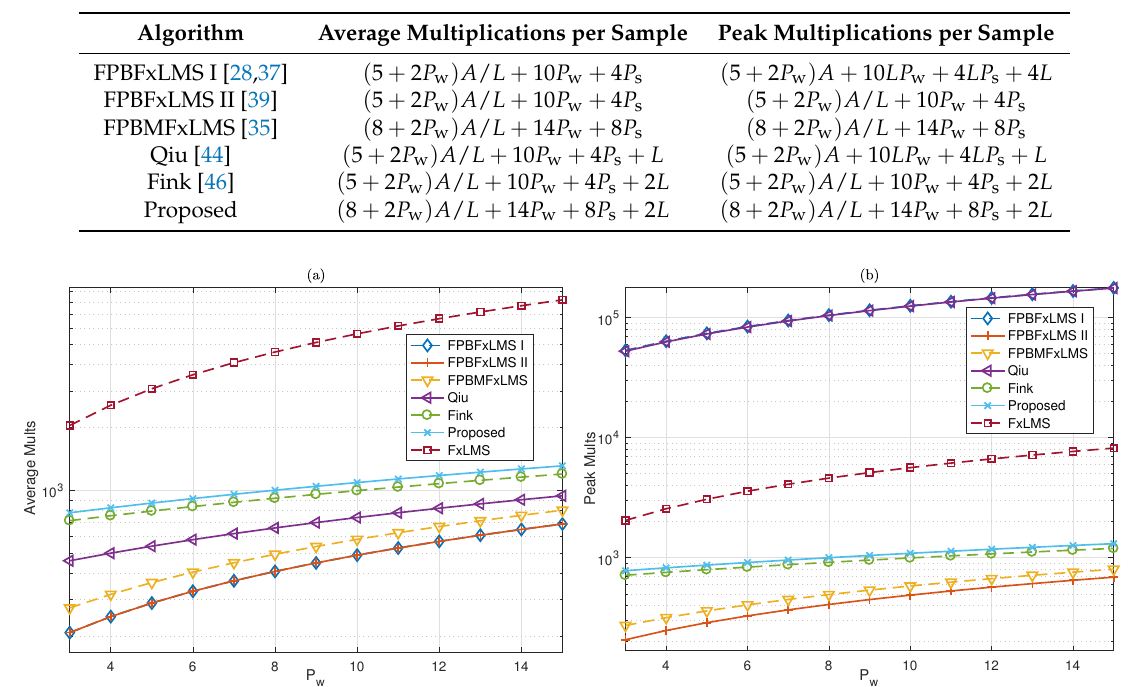
Table 9. Complexity of the frequency-domain ANC algorithms.